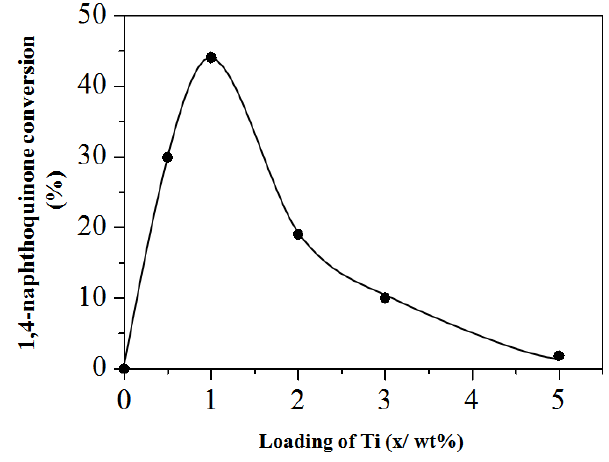
Figure 10. Catalytic performance of Ti ‐ SiNS on oxidation of 1 ‐ naphtol to 1,4 ‐ naphtoquinone.